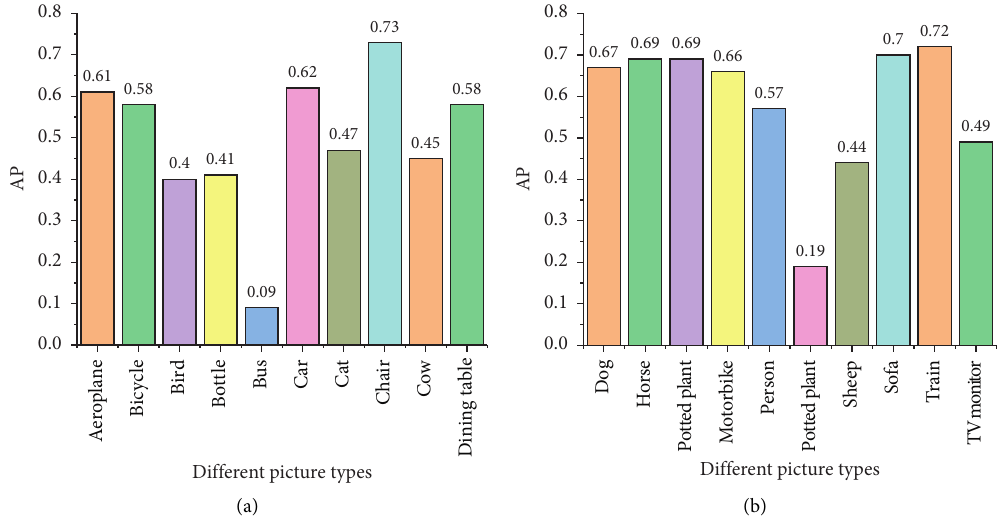
Figure 8: Target category and corresponding AP in model test results.